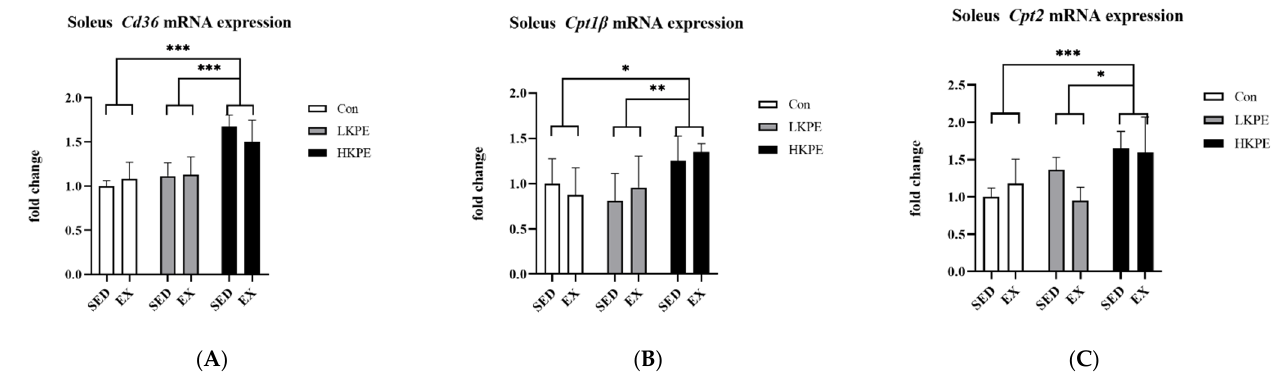
Figure 4. mRNA expression of ( A ) Cd36 , ( B ) Cpt1 β , and ( C ) Cpt2 in soleus muscle immediately after exhaustion. Cd36 , CD36 molecule; Cpt , carnitine palmitoyl transferase; SED, sedentary; EX, exercise; Con, control; KPE, Kaempferia parviflora administration; * p < 0.05, ** p < 0.01, *** p < 0.001.